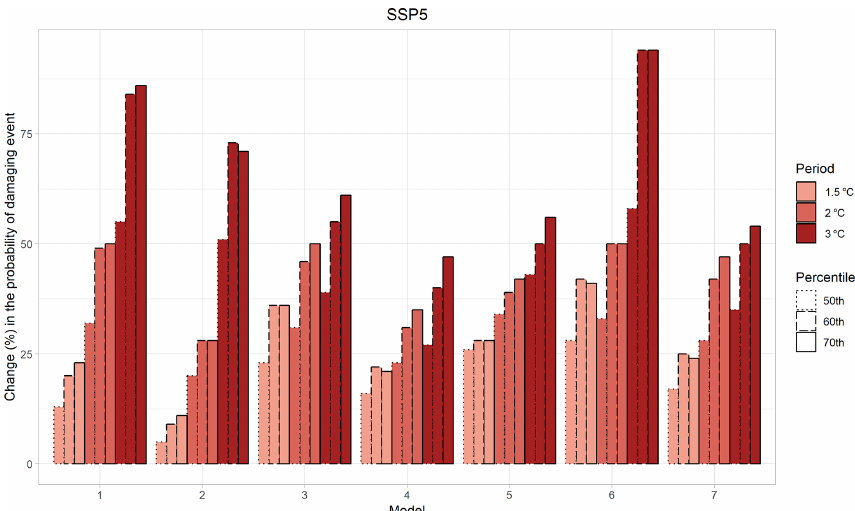
Figure 11. Change in the probability of a damaging event in the Valencian Community with respect to the reference period (1976–2005) for the 50th, 60th and 70th damage percentiles and for all models when using the SSP5 socioeconomic scenario. Different hatching around bars shows the different percentiles of damage.